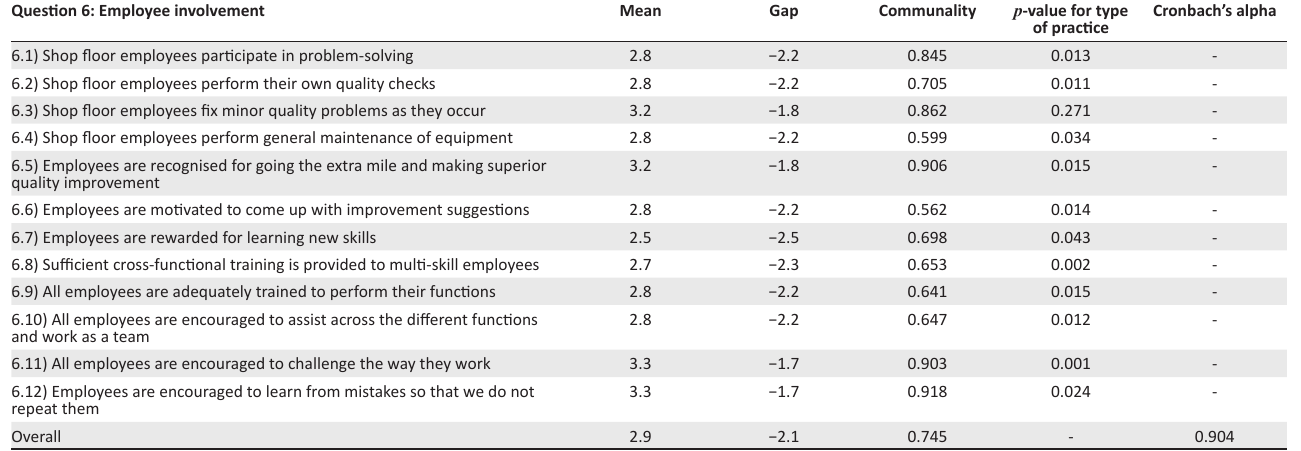
TABLE 7: Results pertaining to employee involvement. Question 6: Employee involvement